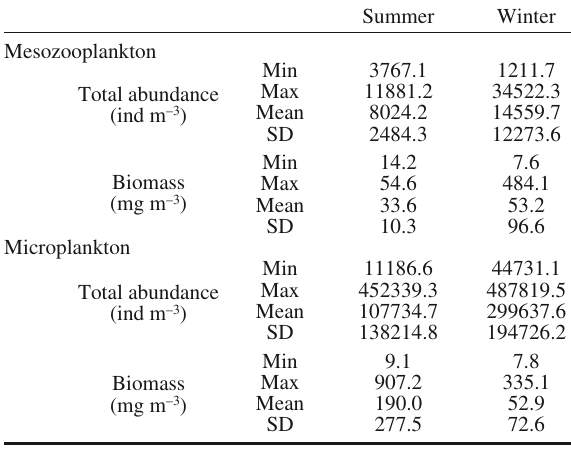
Fig. 6. – Stomach contents for the juveniles and adults of sardine in number (N) and in carbon content (C) of prey. Table 5. – Mean mesozooplankton and microplankton stock in terms of abundance and biomass during the two periods (Min, minimum; Max, maximum; SD, standard